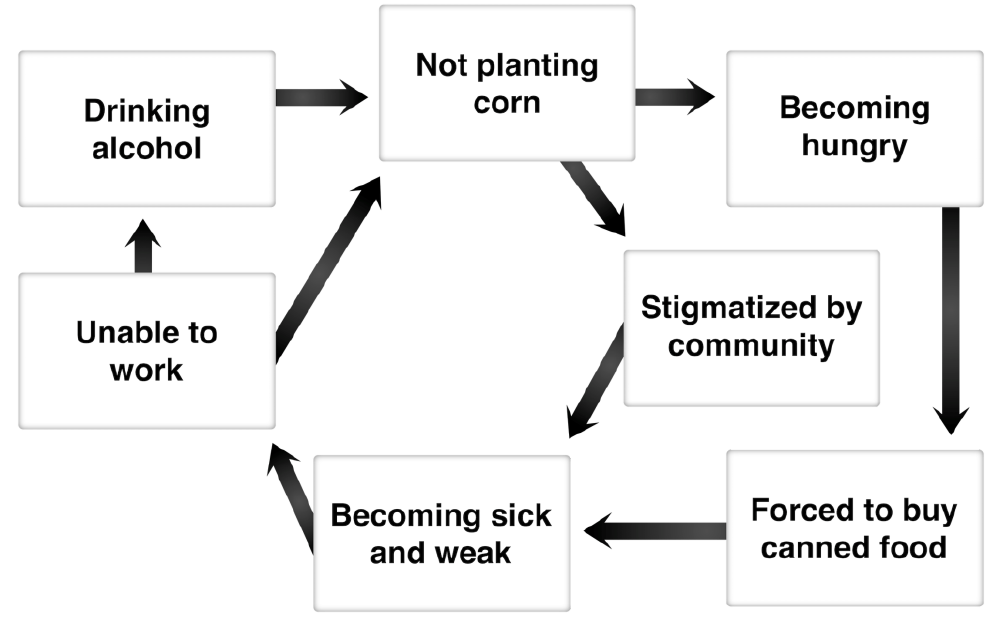
Figure 2. Phenomenological processing loop: Alcohol as unhealthy (original version printed in Baines 2011, reprinted in Baines